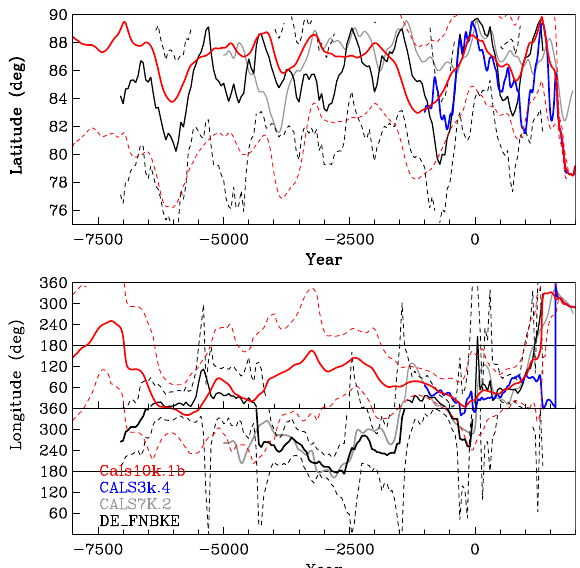
Fig. 4. Latitude (top) and longitude (bottom) of the northern geomagnetic pole location represent tilt and tilt direction of the magnetic dipole axis. Estimates are from spherical harmonic models CALS10k.1b (red with bootstrap uncertainty estimates as dashed lines), CALS3k.4 (blue), CALS7K.2 (grey) and the VGP recon- struction DE FNBKE (black with uncertainty estimates as dashed